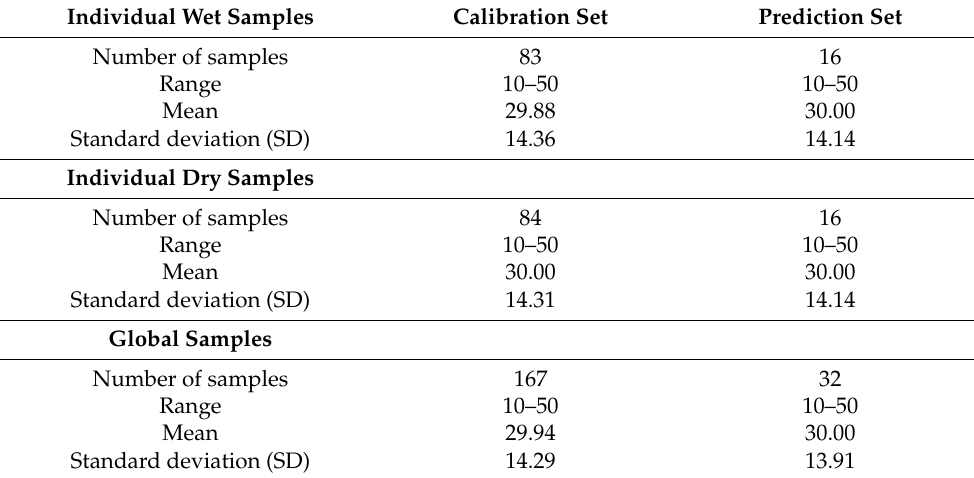
Table 1. Individual and global peaberry wet and dry-processed samples with 10–50% of corn adulteration in calibration and prediction sets. The range, mean, and standard deviations were expressed in % ( w / w